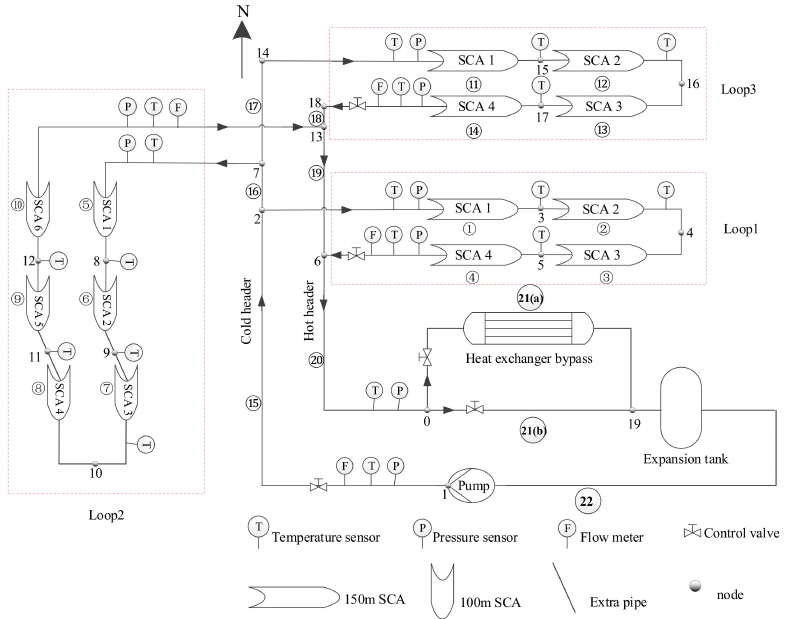
Figure 2. Flow diagram, nodes, and pipe section label of the parabolic trough solar field (PTSF) in the pilot